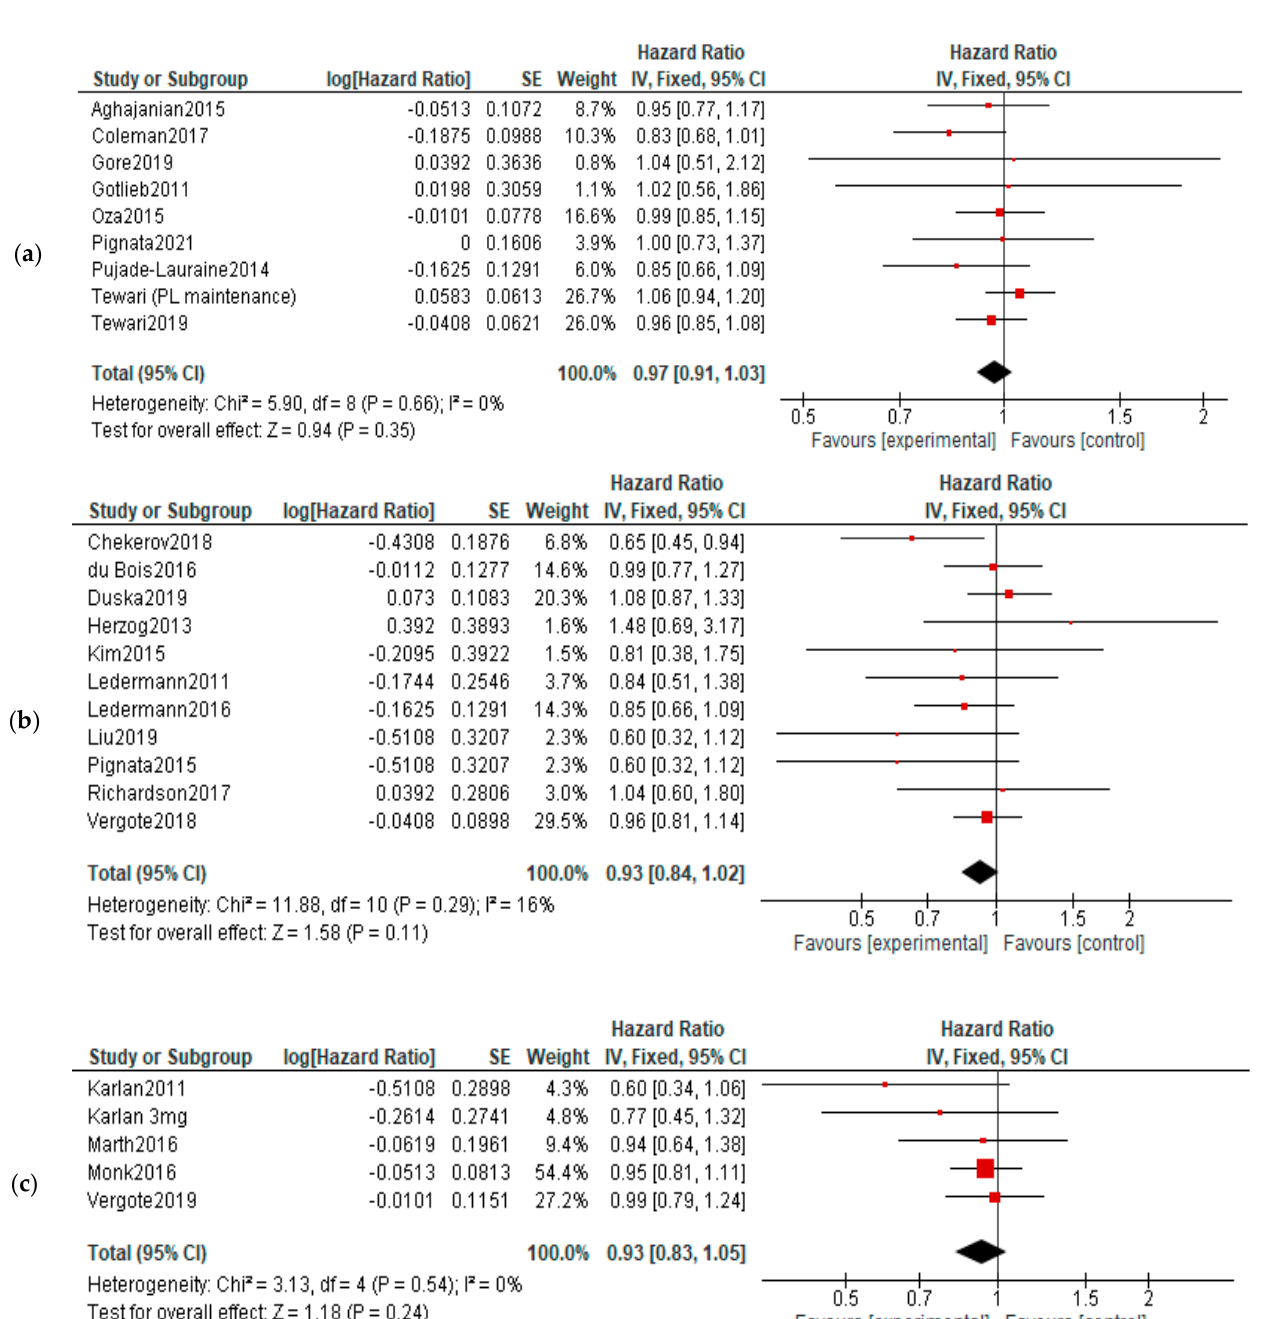
Figure 5. Action-mechanisms subgroup analysis of progression: ( a ) VEGF inhibitors, ( b ) VEGF-R inhibitors and ( c ) angiopoietin inhibitors. The black diamonds are visual representations of pooled effect and its confidence intervals and are non-significant if they overlap 1. Red squares represent each study effect size and study weight (size of square). The lines represent each study confidence